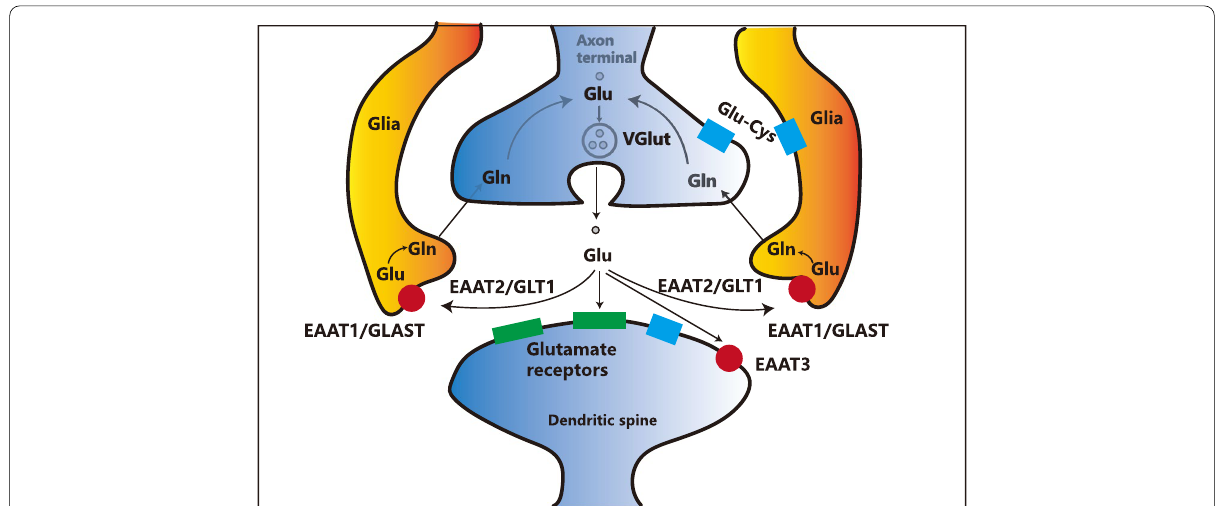
Fig. 6 Role of glutamate transporters at glutamatergic synapases. The glutamate transportation includes synaptic release, extrasynaptically by exocytosis and the release of cystine-glutamate antiporter.To terminate the action of glutamate and maintain its extracellular concentration below excitotoxic levels, Na -dependent high affinity glutamate transporters (EAATs)located on the plasma membrane of neurons and glial cells rapidly + remove glutamate from the extracellular space. Gln Glutamine, Glu Glutamate, VGlut Vesicular glutamate